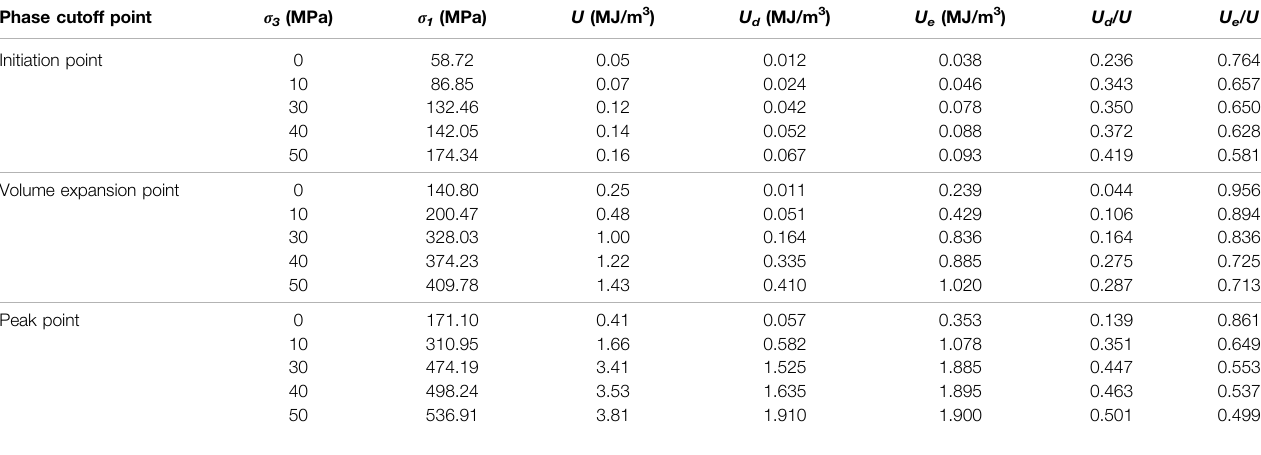
Volume expansion